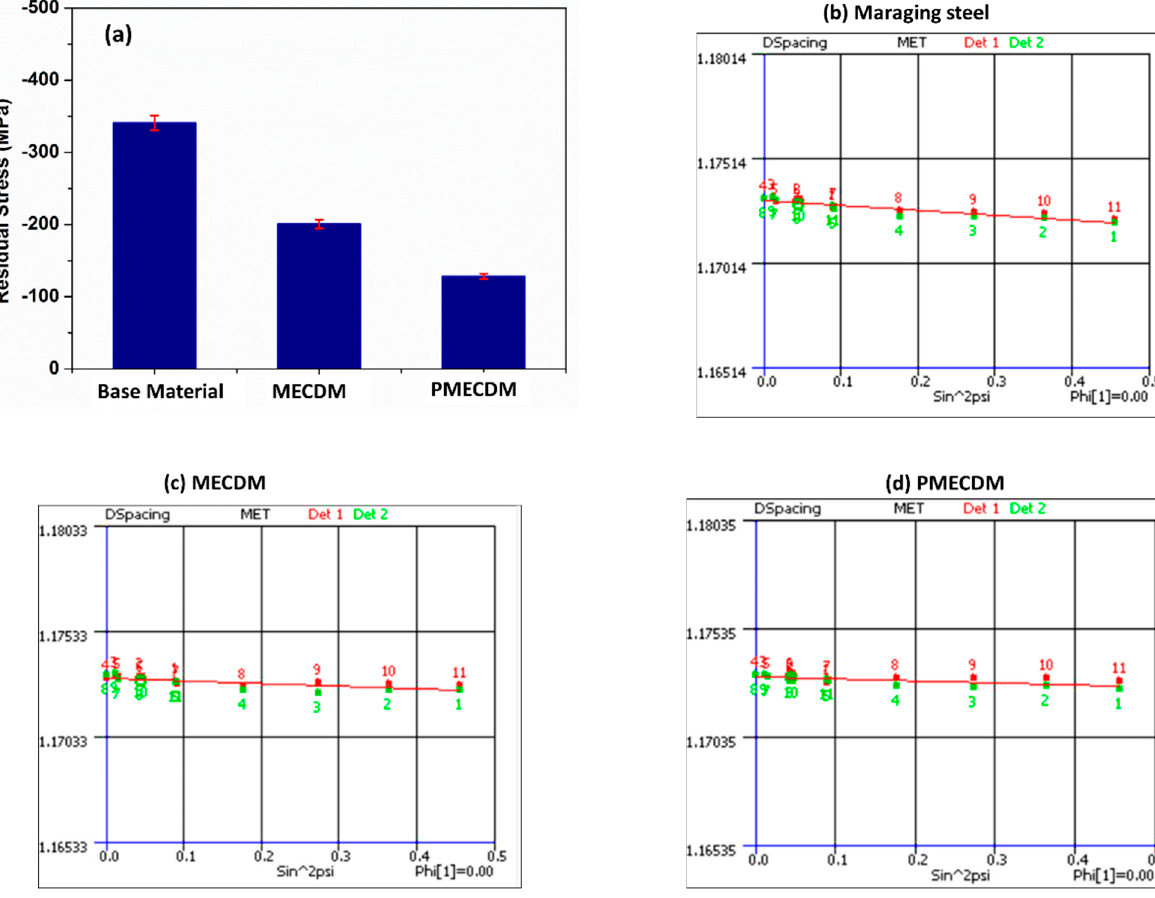
Figure 9. Comparison of residual stresses for different samples.